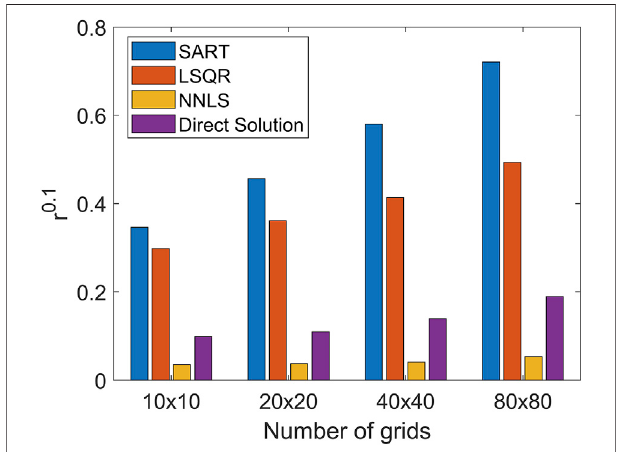
FIGURE 10 | The in fl uence of the number of grids on the reconstruction